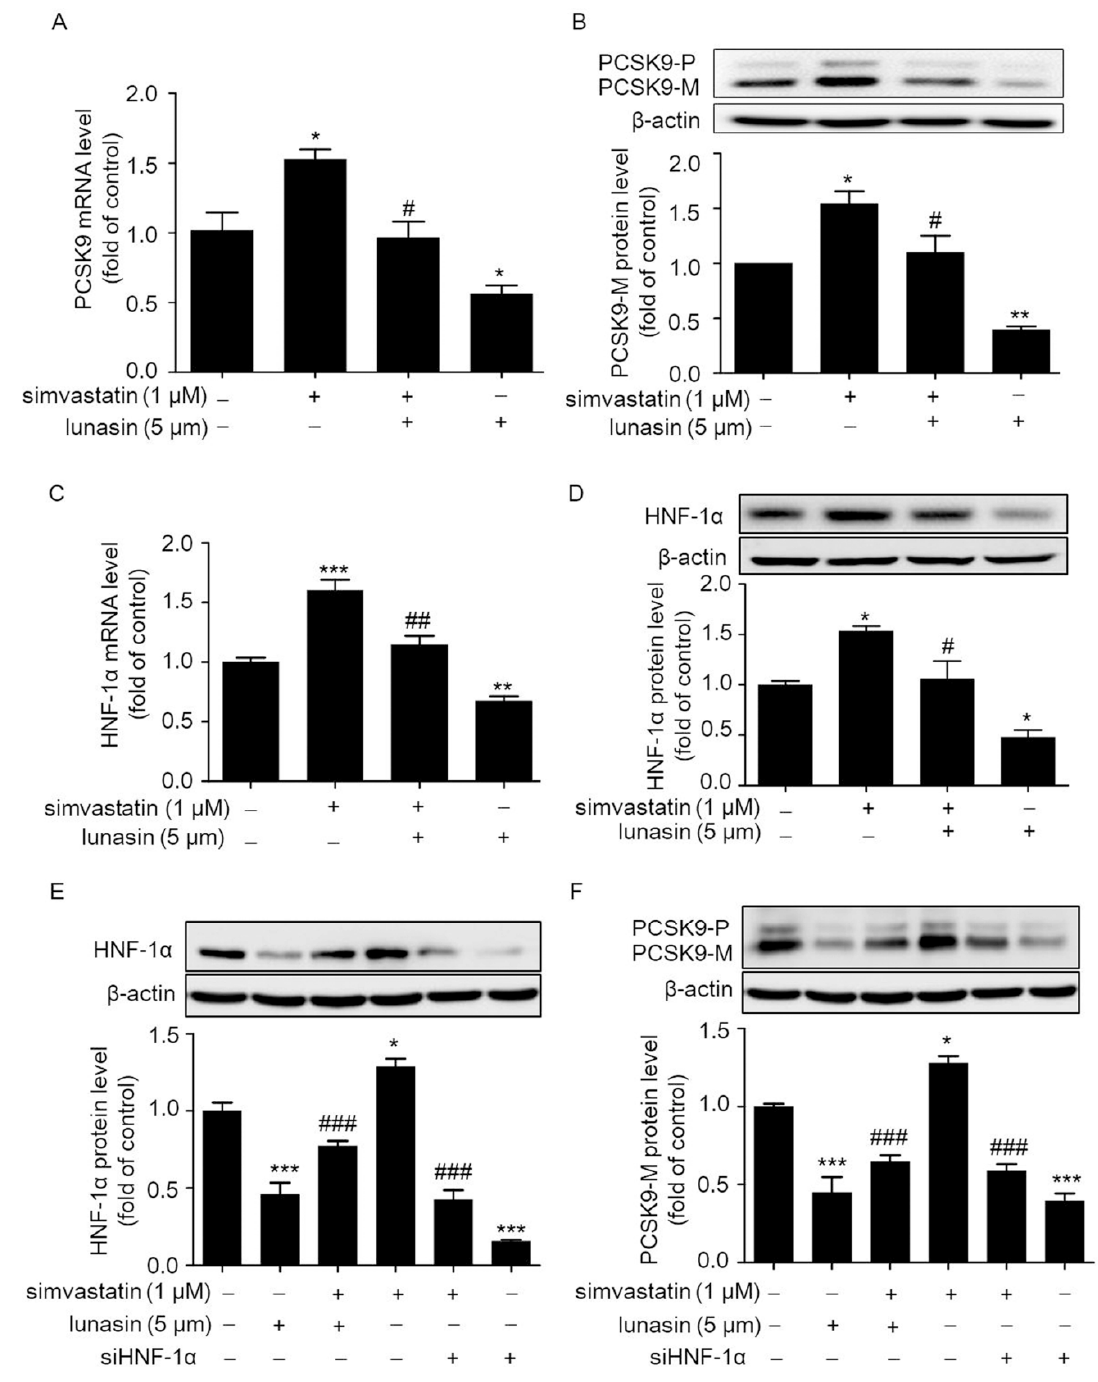
Figure 1. E ff ects of simvastatin combined with lunasin treatment on PCSK9 and HNF-1 α expressions at the mRNA and protein levels in HepG2 cells. HepG2 cells were treated with simvastatin and / or lunasin for 24 h. The mRNA ( A ) and protein ( B ) levels of intracellular precursor PCSK9 (PCSK9-P) and mature PCSK9 (PCSK9-M), as well as the mRNA ( C ) and protein ( D ) level of HNF-1 α were determined by qRT-PCR and Western blot using β -actin as an internal control, respectively. After transient transfection with siRNA for 4 h, EA.hy 926 cells were maintained in fresh medium for 48 h and treated with 1 µ M lunasin for an additional 24 h. Then, the levels of HNF-1 α ( E ) and PCSK9 ( F ) protein expression were analyzed by Western blot analyses, respectively. * p < 0.05, ** p < 0.01, *** p < 0.001 vs. the control group; # p < 0.05, ## p < 0.01, ### p < 0.001 vs. the simvastatin group ( n = 3, means ± SEM).